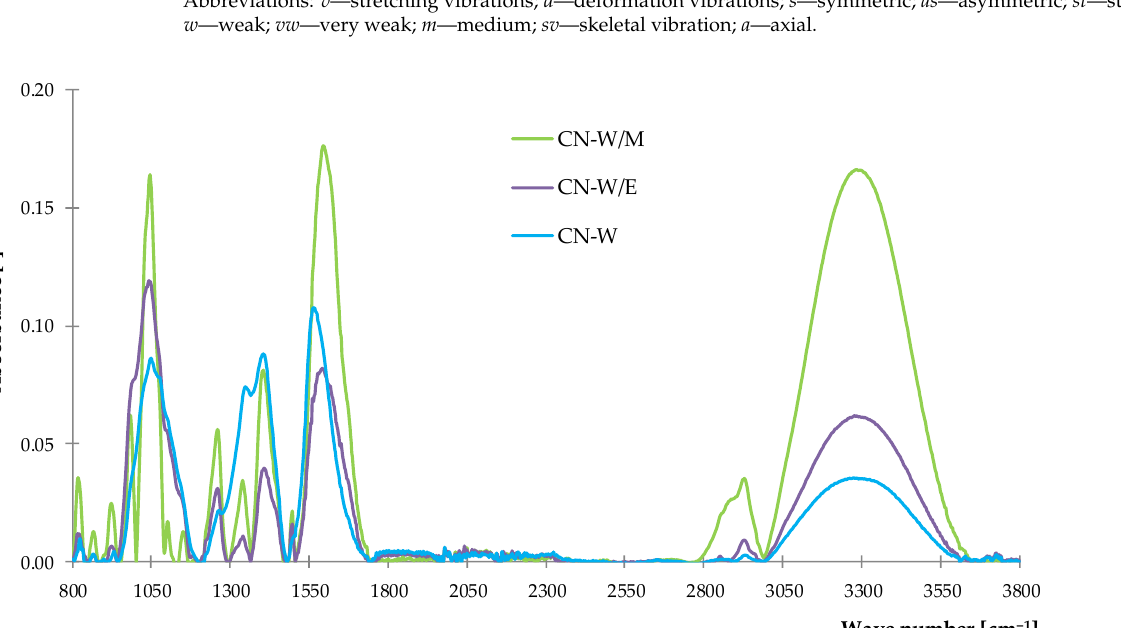
Figure 1. The FTIR spectra of common nettle freeze-dried extracts.